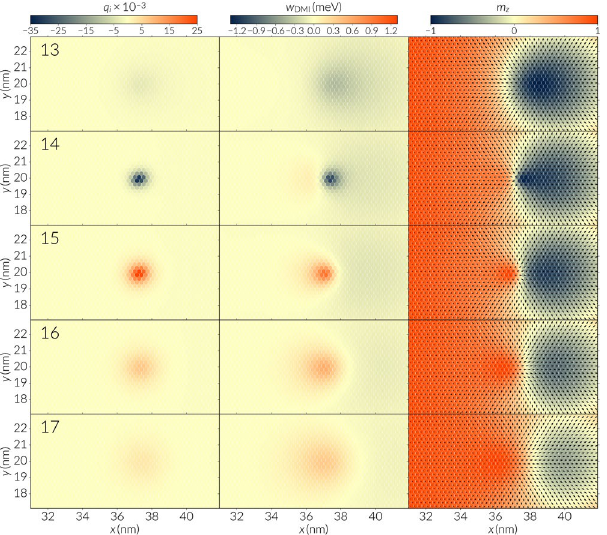
Figure 7. Skyrmion destruction mediated by a topological singularity. The sequence shows the snapshots of the energy band images for an nanotrack system of DMI constant D = 0.721 meV, described by a hexagonally arranged discrete spin lattice. This band corresponds to the annotated curve of Fig. 6a. The left column shows the topological charge density, the middle sequence the DMI energy density per lattice site and the right column the corresponding magnetisation fields. The hexagonal mesh can be distinguished from the honeycomb shaped data points. The numbers at the top left of every row indicate the image number from the energy